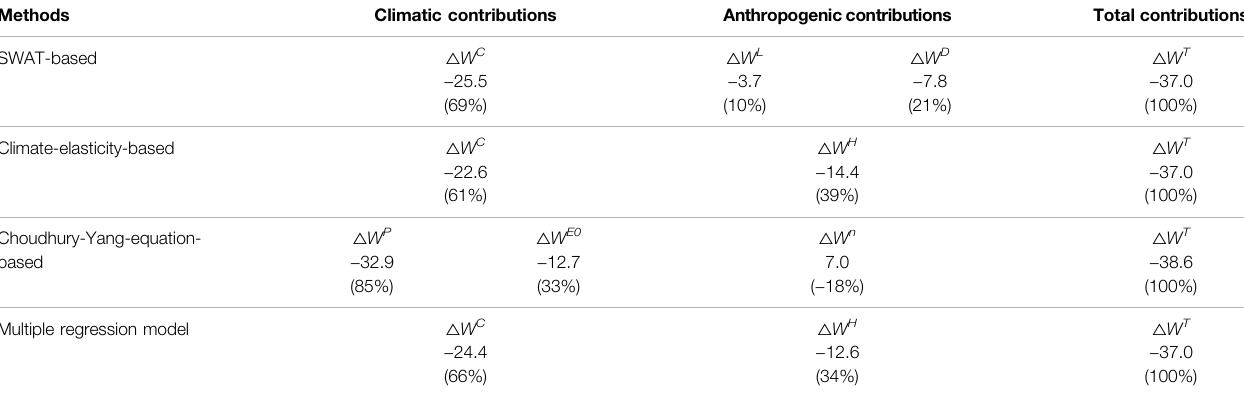
TABLE 3 | Climatic and anthropogenic contributions to stream fl ow